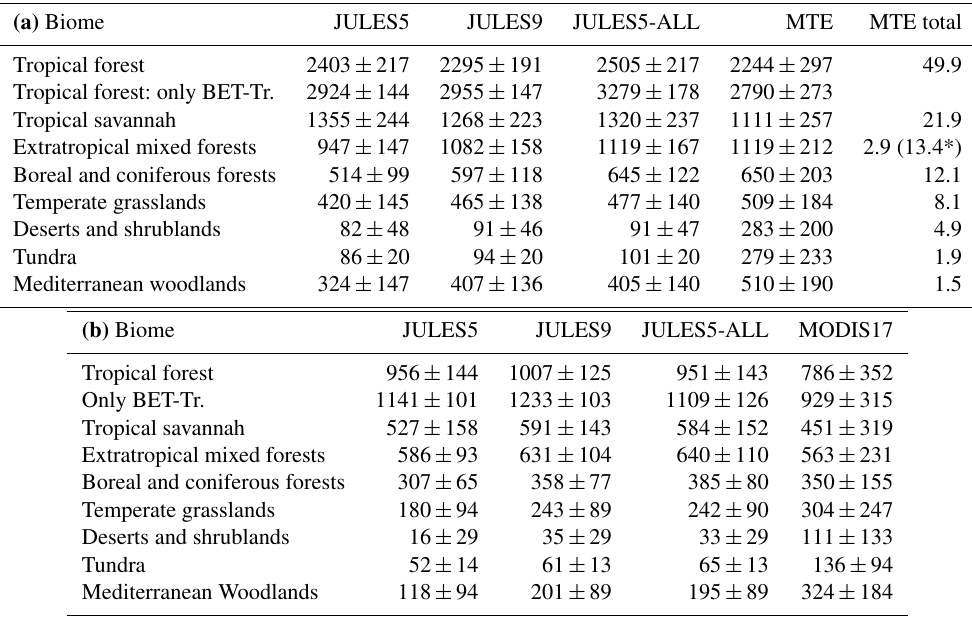
Table 6. (a) Area-weighted GPP from each biome (gCm − 2 year − 1 ) . The biome total GPP from MTE is given in PgCyear − 1 to give perspective of each biome’s role in the global total. (b) Area-weighted NPP from each biome (gCm − 2 yr − 1 )